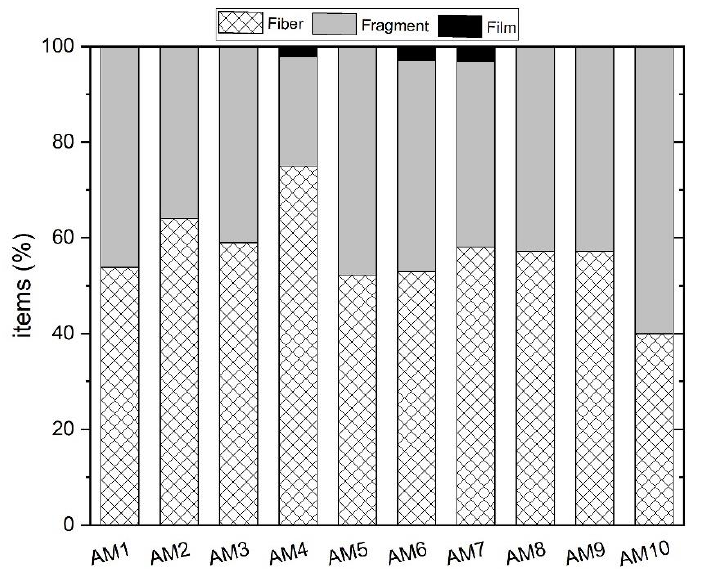
Figure 6. Fibers, fragments, and films (%) repartition of MP* in the MC sediments.